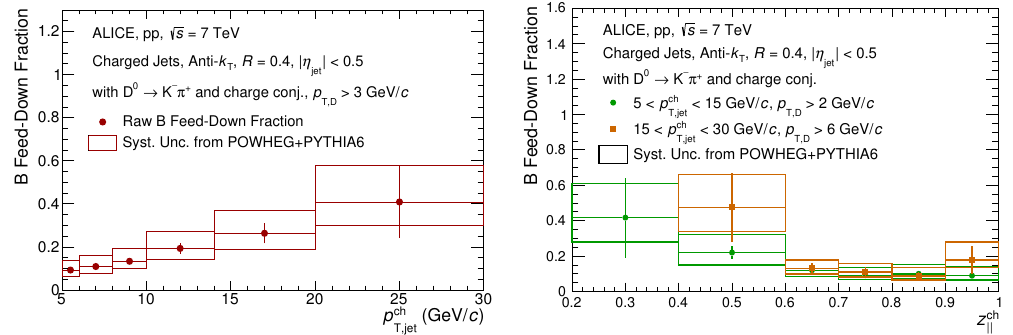
Figure 3 . b-hadron feed-down fraction of D 0 -meson tagged jets as a function of p ch p (right) in pp collisions at s = 7 TeV. On the right, the fraction is shown for 5 < p ch (circles) and for 15 < p ch < 30 GeV =c (squares). The boxes represent the systematic uncertainties, T ; jet see section 5 for